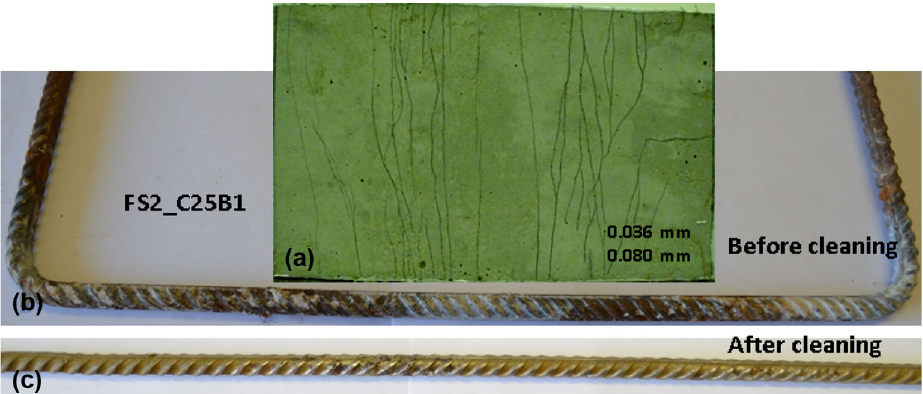
Fig. 6 Inspection of corrosion damage in an R/SHCC specimen.